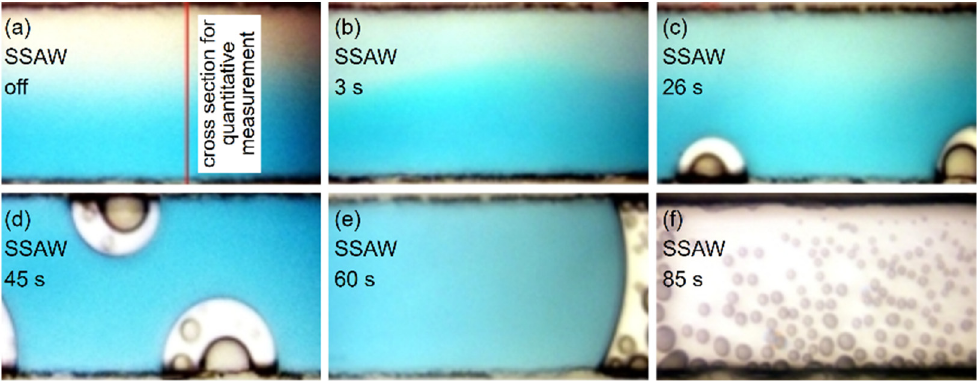
Figure 3. Top view of the channel in our SSAW-based mixing device (input voltage 6 V, 50 × amplified): ( a ) SSAW off; ( b ) 3 s after SSAW was switched on; ( c ) 26 s after SSAW was switched on; ( d ) 45 s after SSAW was switched on; ( e ) 60 s SSAW after was switched on; ( f ) 85 s after SSAW was switched on.